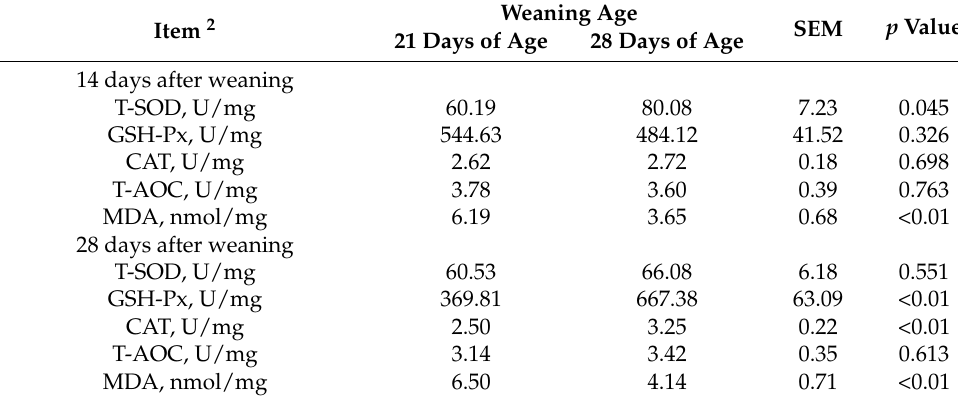
Table 11. Effect of weaning age on jejunum antioxidant indexes of weaned pigs 1